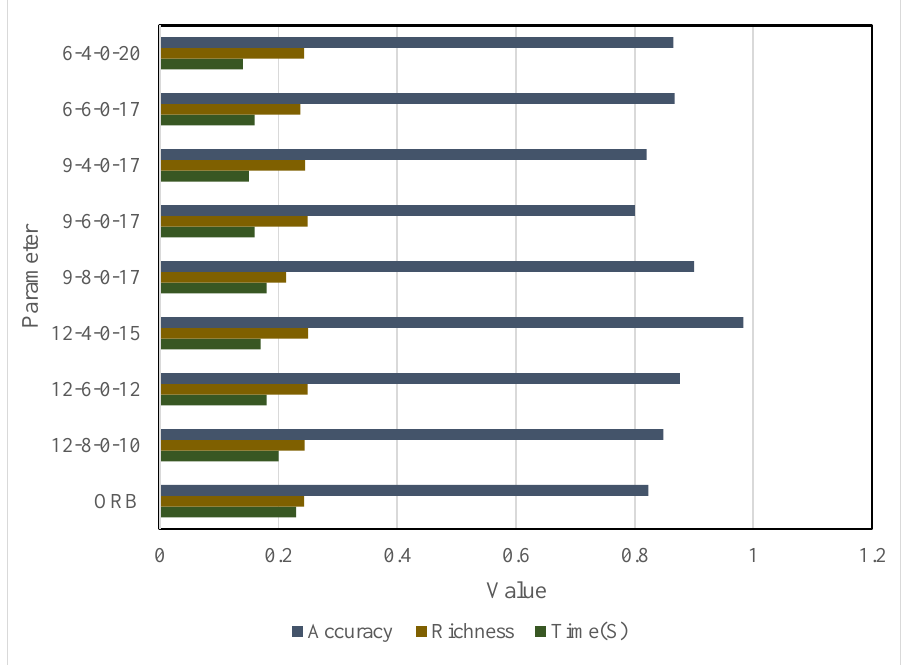
Figure 5. Performance comparison of the improved ORB algorithm.